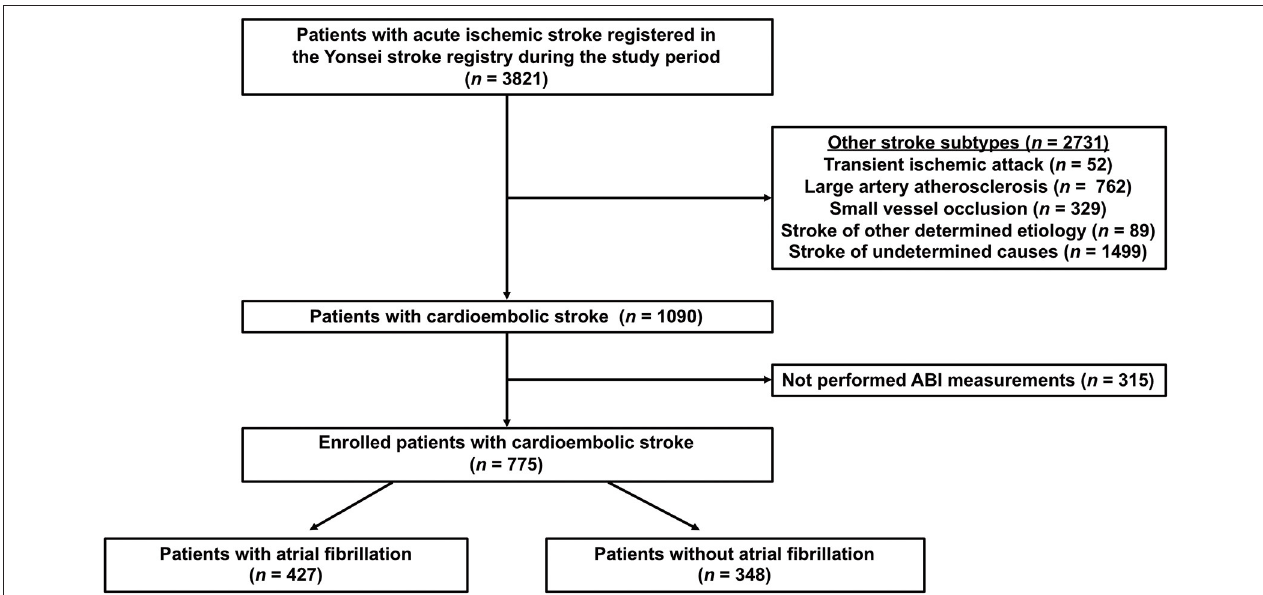
FIGURE 1 | Flowchart of participants according to inclusion and exclusion criteria. ABI, ankle-brachial